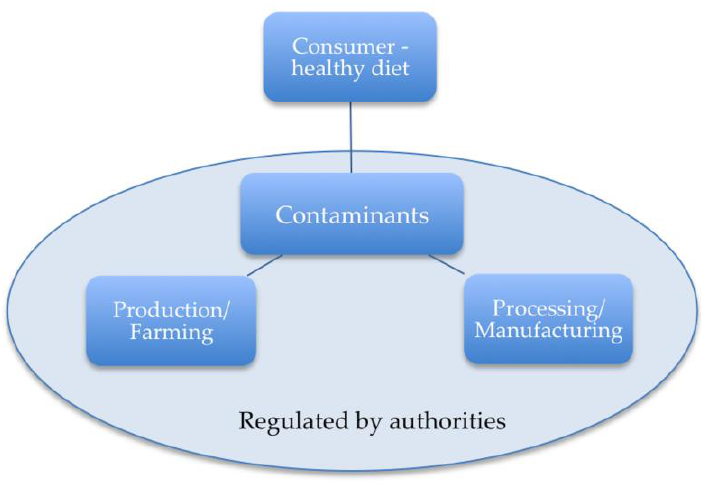
Figure 3. Important players to mitigate the impact of